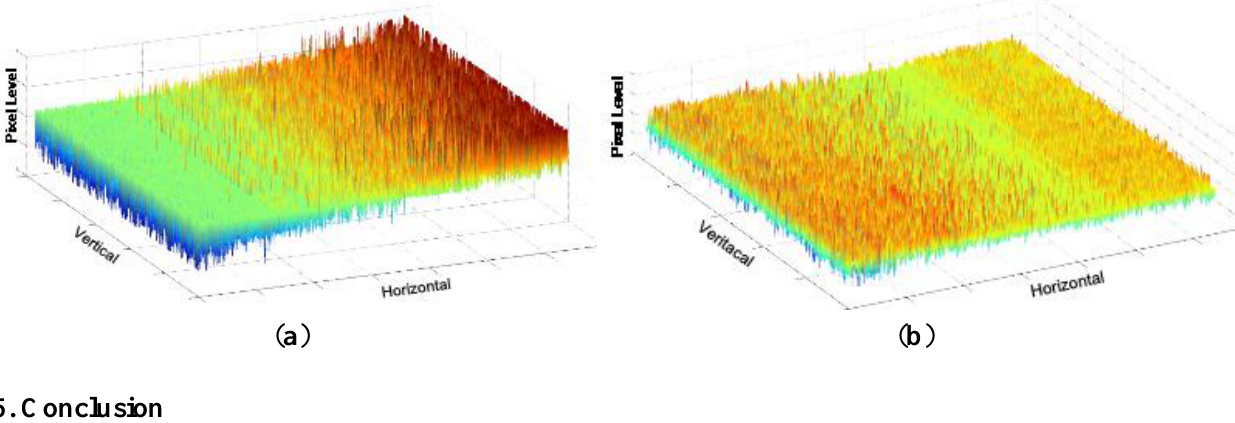
Figure 20. Measured results for the variation of pixel level: ( a ) without the digital CDS; ( b ) with the digital